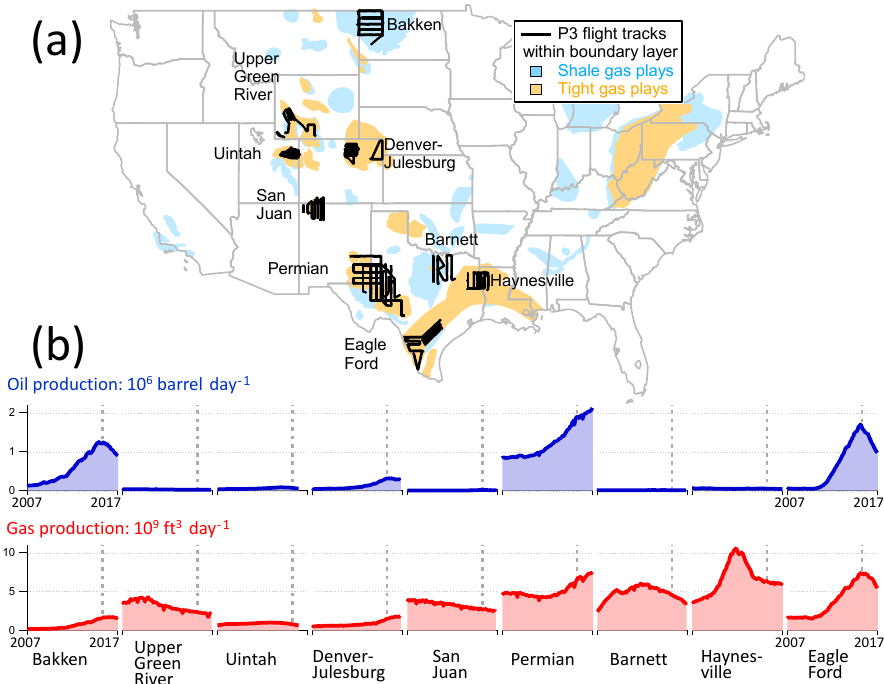
Figure 1. (a) SONGNEX study regions and P3 flight tracks. (b) Oil and natural gas production over time in various regions. The vertical dashed gray line marks the time period of the SONGNEX measurements. Production data from US Energy Information Administration (2017), Colorado Oil and Gas Conservation Commission (2017), State of New Mexico Oil Conservation Division (2017), Railroad Commis- sion of Texas (2017), Wyoming Oil and Gas Conservation Commission (2017), and State of Utah Division of Oil Gas and Mining